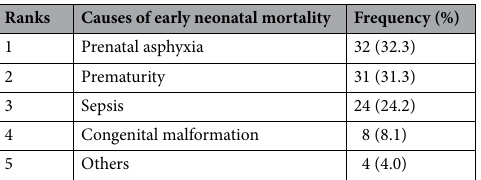
Table 3. Top causes of early neonatal mortality at NICU, Referral Hospital from May 2019 to May 2021.